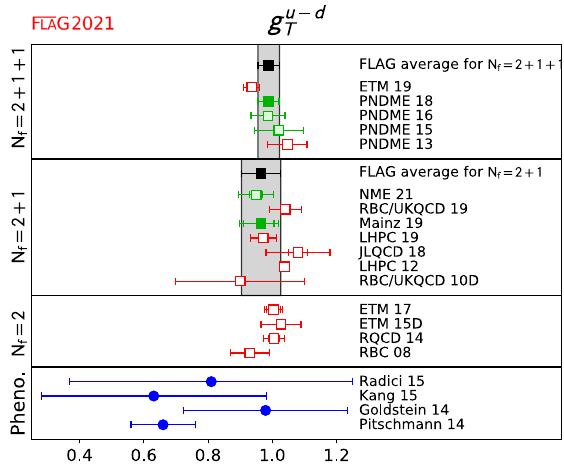
Fig. 45 Lattice results and FLAG averages for the isovector tensor charge g u − d are phenomenological results using measures of transversity [986–990]